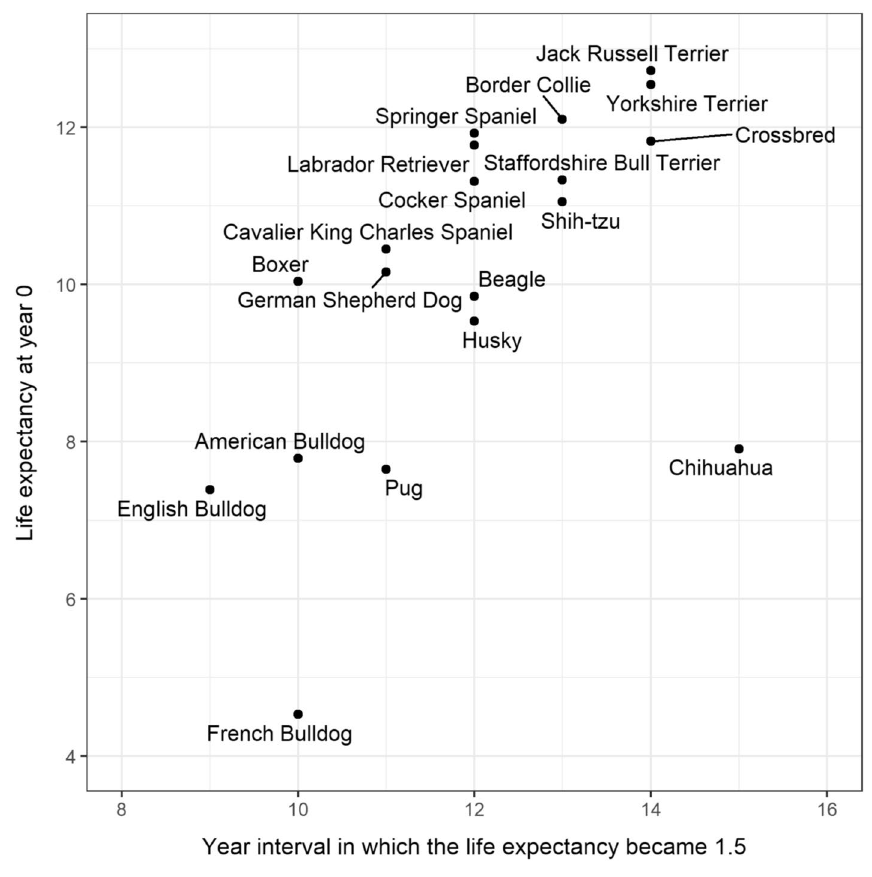
Figure 3. Relation between the life expectancy at year 0 and year interval in which the life expectancy became 1.5 in 18 breeds and crossbred under primary veterinary care in the